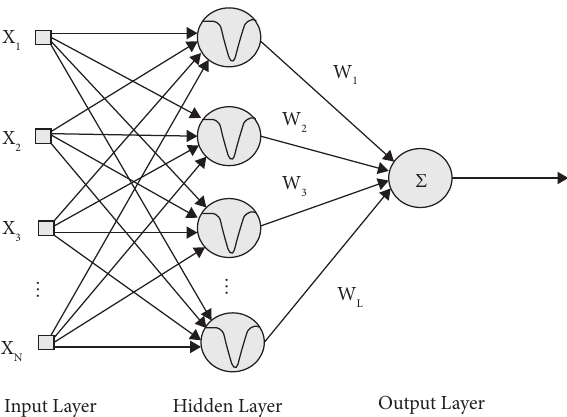
Figure 4: An RBF network